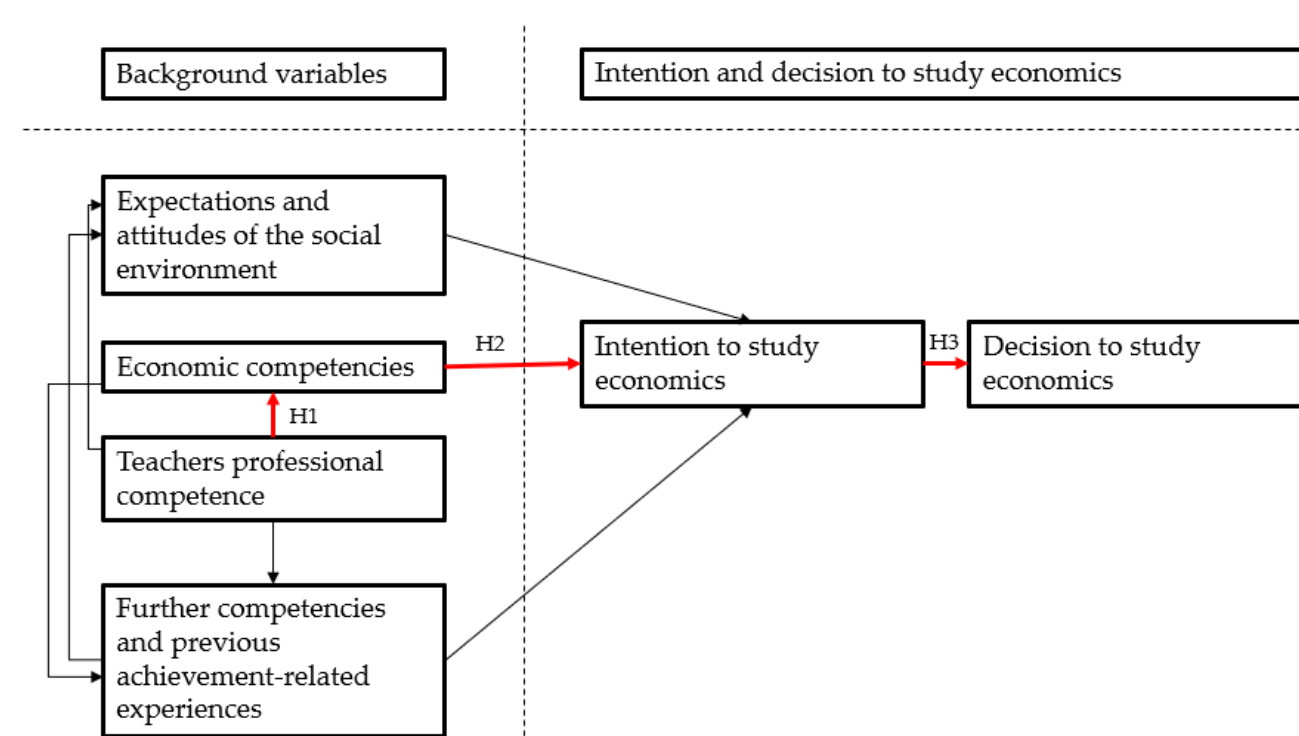
Figure 2. Adjusted and Simplified Expectancy–Value Model with a Theoretically Modeled Path.